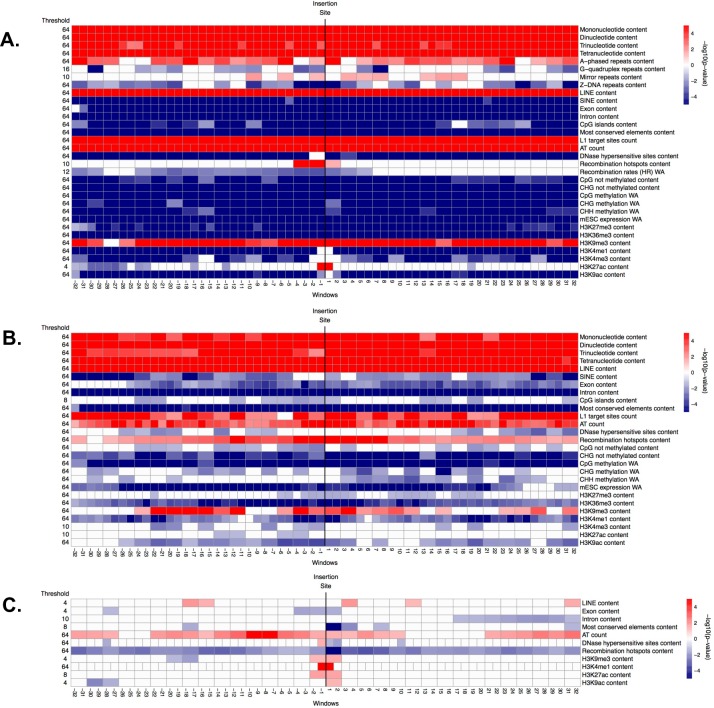
Significance (i.e. -log10(corrected p-value)) of genomic features in windows along the flanking regions, obtained from the ITP using the mean difference as test statistics: (A) fixed ETns vs. controls, (B) polymorphic ETns vs. controls, and (C) fixed vs. polymorphic ETns. In each panel, the horizontal axis represents the 64 1-kb windows. The vertical black line between window -1 kb and 1 kb marks the integration site. The thresholds reported on the left represent the maximum scale at which each feature is significant, ranging from 64 kb (coarsest) to 1 kb (finest). Each row corresponds to one feature and each cell represents one or two contiguous windows, depending on the number of nodes employed in the B-splines (we consider one value for every 1-kb window when using the raw data, and one value every two 1-kb windows when using the piecewise constant smoothed version of the data). White cells: not significant (p-value >0.05), red cells: significant with higher mean in the flanking regions of ETns vs. controls (or in the flanking regions of fixed vs. polymorphic ETns), blue cells: significant with lower mean in the flanking regions of ETns vs. controls (or in the flanking regions of fixed vs. polymorphic ETns). Color intensity is proportional to significance (more intense colors correspond to lower corrected p-values).